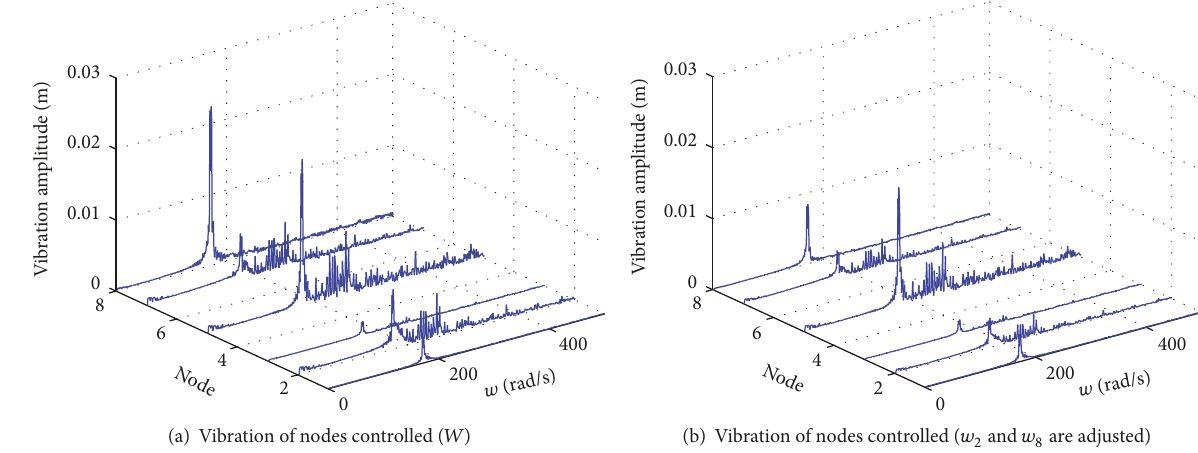
Figure 10: Weighted optimal control for nodes 2 and 8 vibration by adjusting weights 𝑤 2 and 𝑤 8